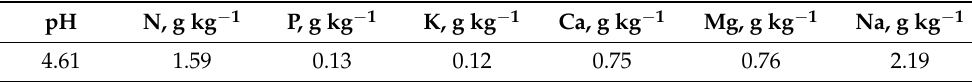
Table 1. The pH value and nutrient content in the sodium lignosulfonate used in the study.